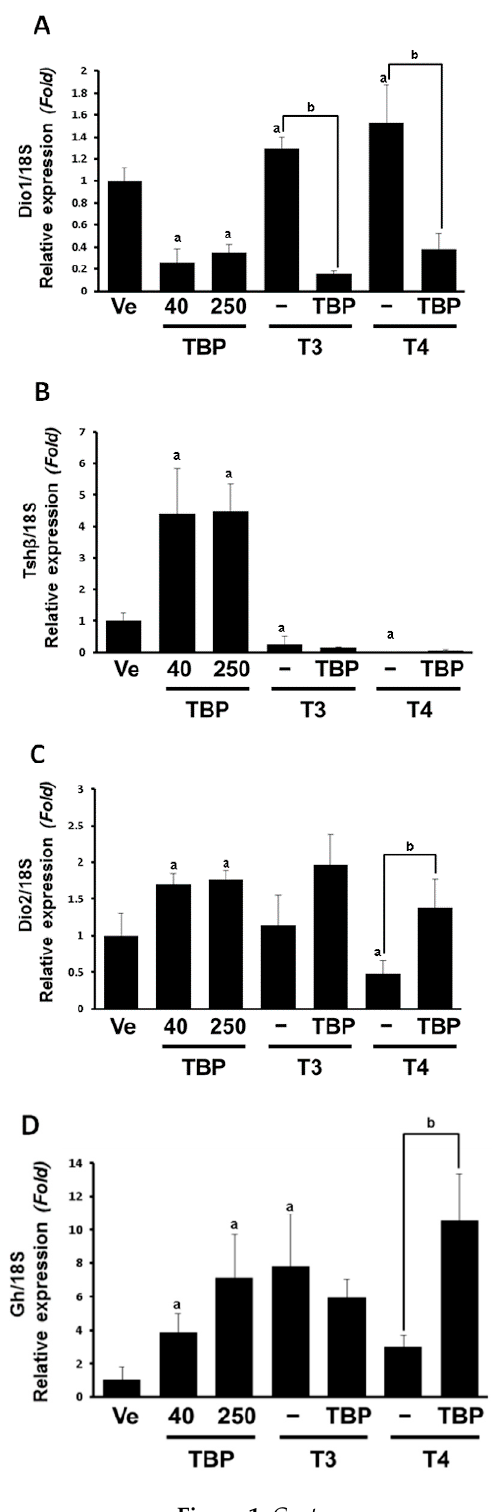
Figure 1. Cont. Figure 1.